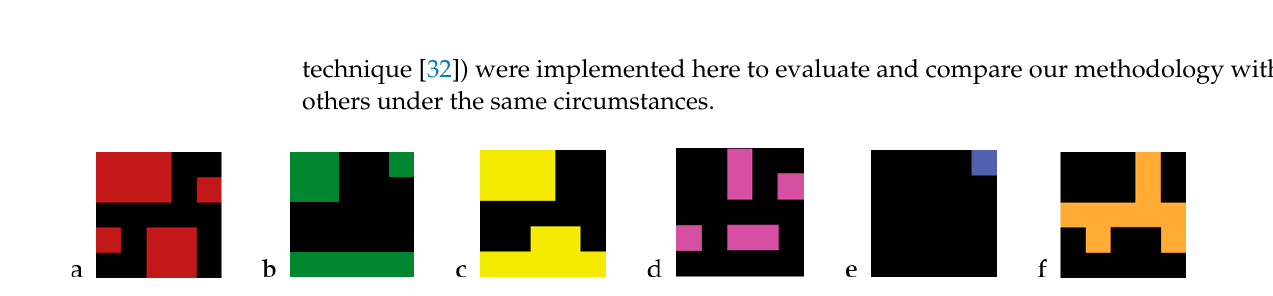
Figure 9. Example of expanded true positive (TP): ground truth (GT) ( a ); segmented pixels ( b ); TP ( c ), false negative (FN) ( d ), false positive (FP) ( e ), and true negative (TN) ( f ).